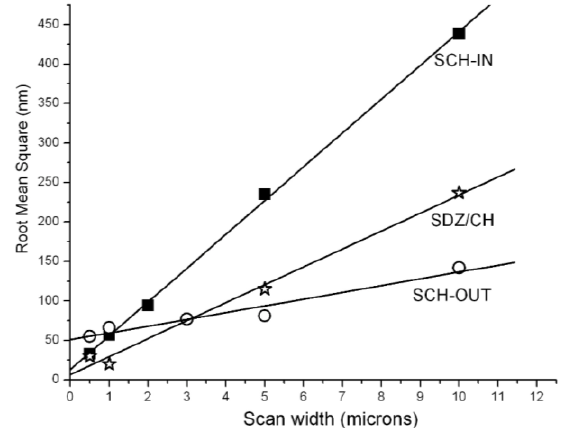
Figure 5. Root mean square roughness (RMS) dependence on the scan width for SCH-IN, SCH-OUT, and CH/SDZ samples.